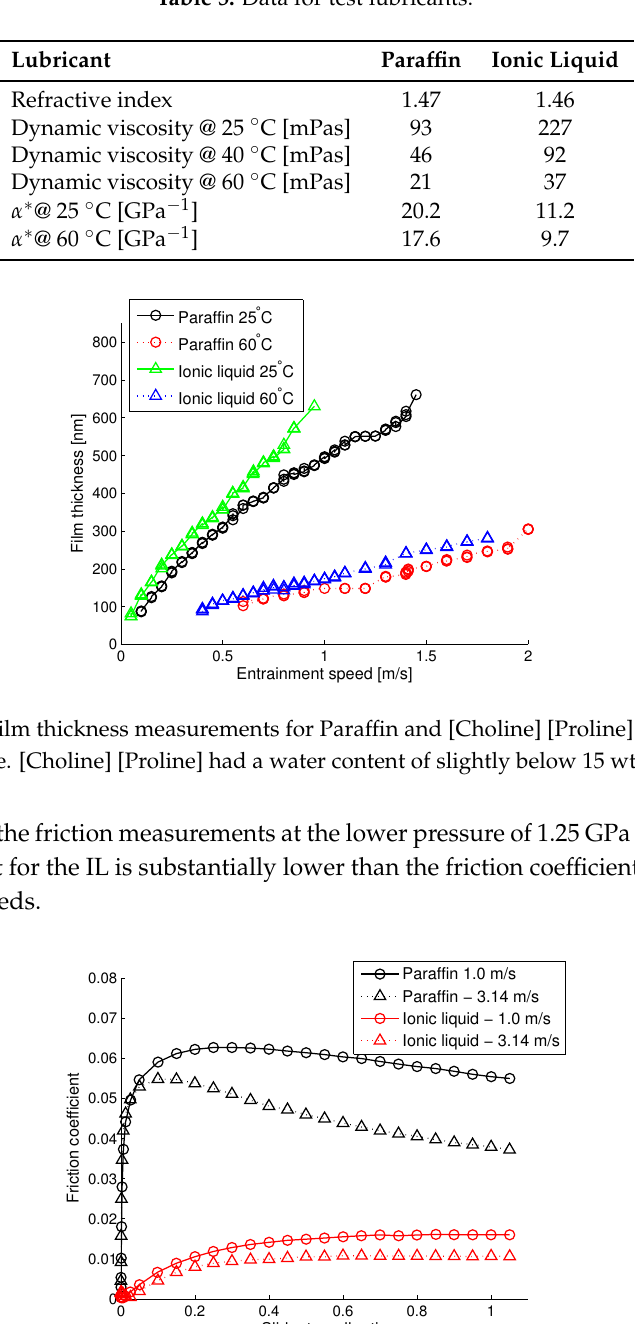
Table 5. Data for test lubricants.